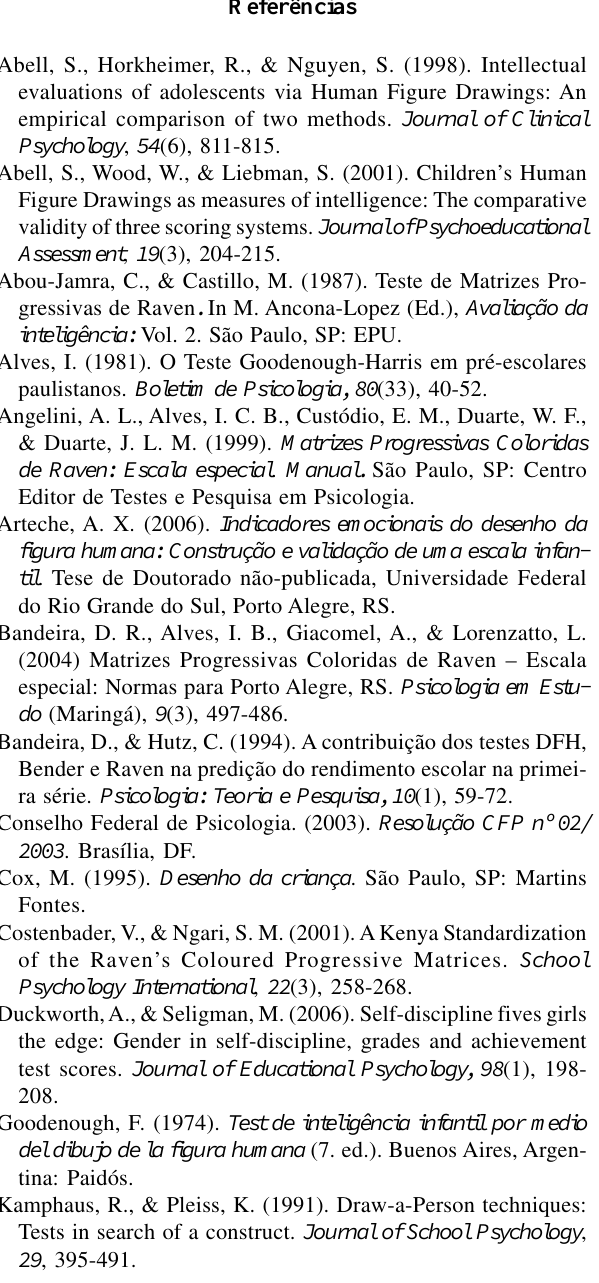
figura humana: Construção e validação de uma escala